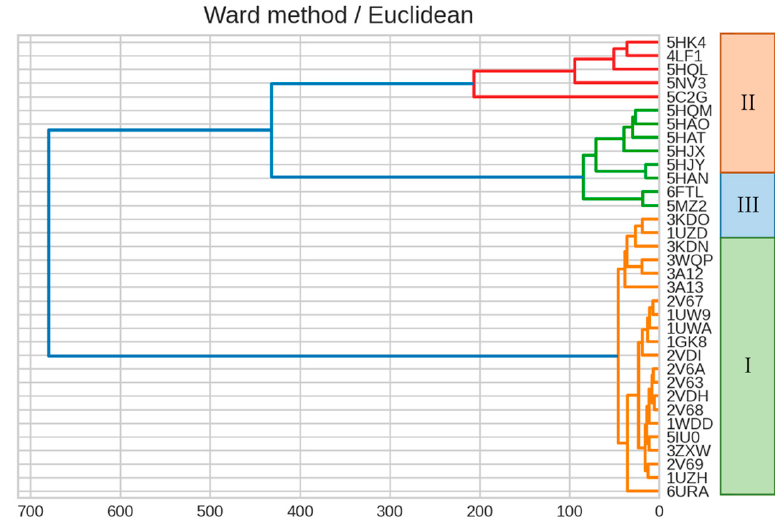
Figure 10. Dendrogram showing the clustering result on IFIE data using Ward’s method. Color coding is set at 60% of the maximum Euclidean distance. The dendrogram was created using 22 sites corresponding to residues surrounding the active site (see Figure 9).